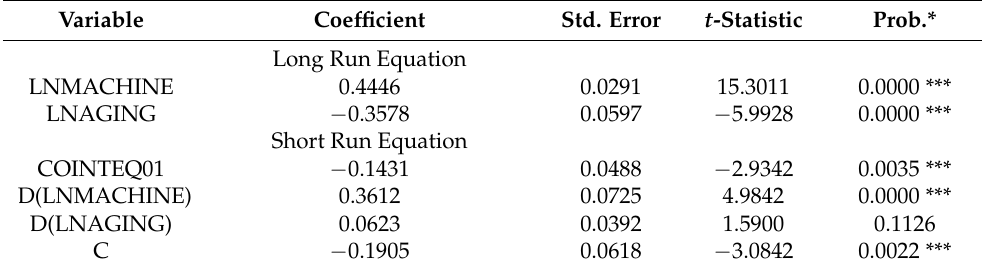
Table 8. The results of